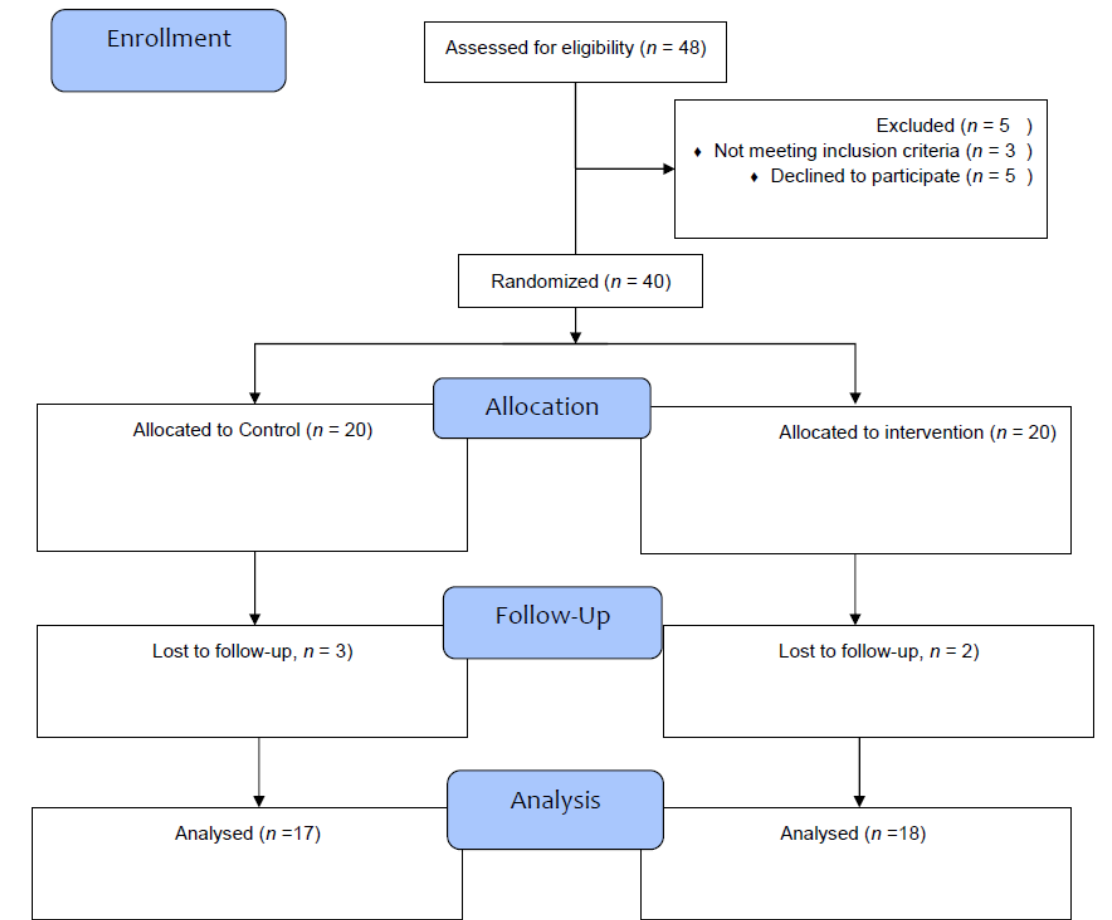
Figure 1. Flow-chart reflecting the number of participants at each state of the study. Table 1. Sociodemographic information of participants in the rTMS and sham